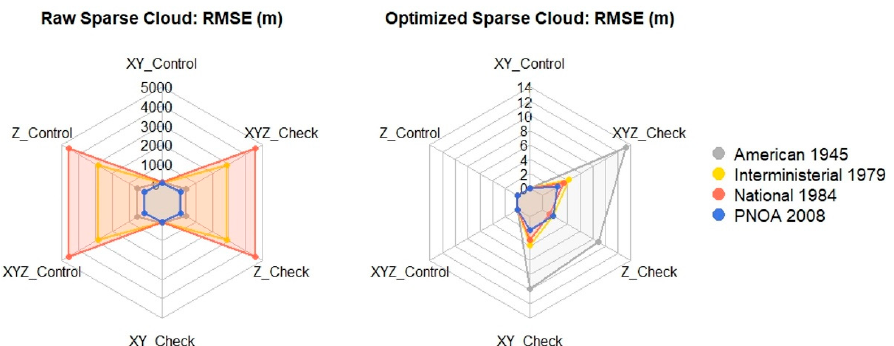
Figure 5. Error comparison between raw and optimized point clouds.